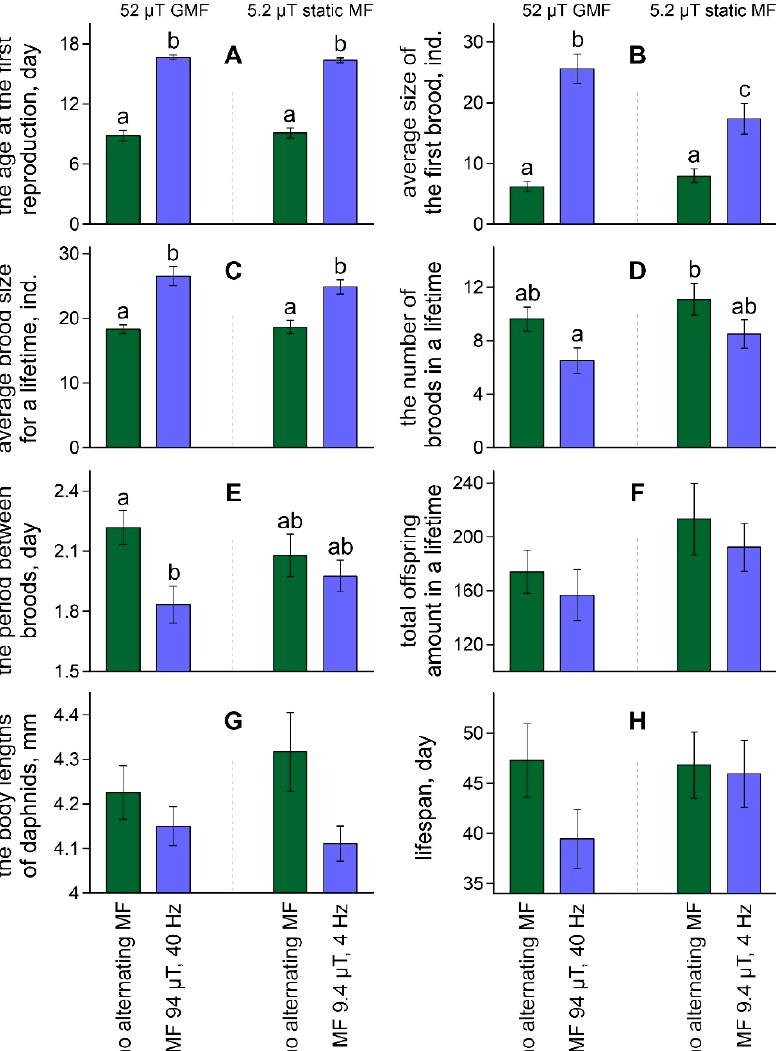
Figure 1. Age at the first reproduction ( A ), size of the first brood ( B ) and averaged brood size for a lifespan ( C ), the number of broods ( D ), the period between broods ( E ), the total offspring amount ( F ), the body lengths of parental daphnids ( G ), and its lifespan ( H ) in the groups of D. magna exposed to studied magnetic fields. Values are means ± standard error. Significant differences ( p < 0.05) among groups after Tukey’s post-hoc multiple comparison tests indicated by different letters.